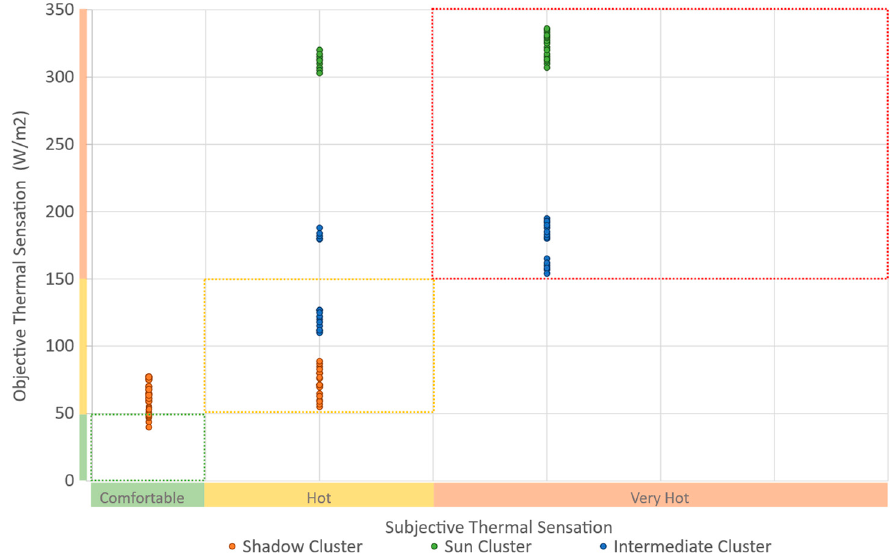
21 of 27 Figure 17. Thermal load calculated by the COMFA model.